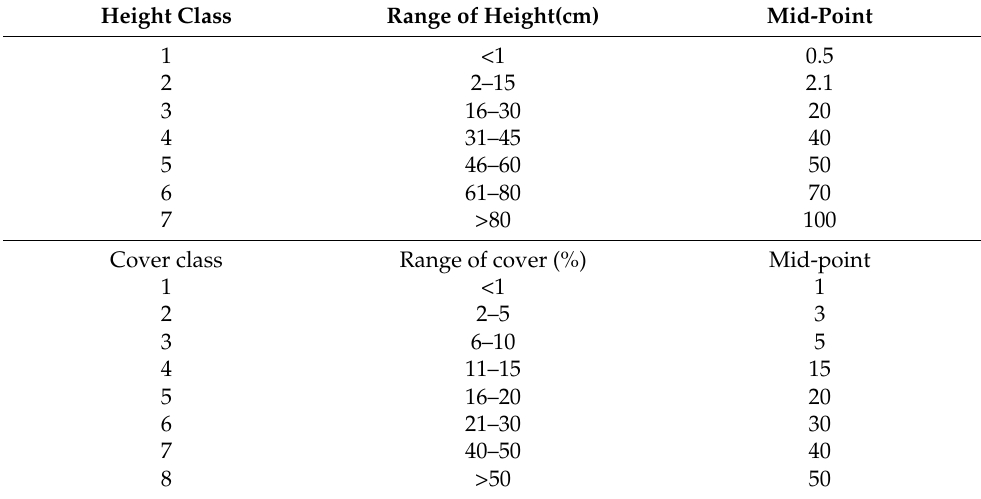
Table 2. Classification of the range of height and cover